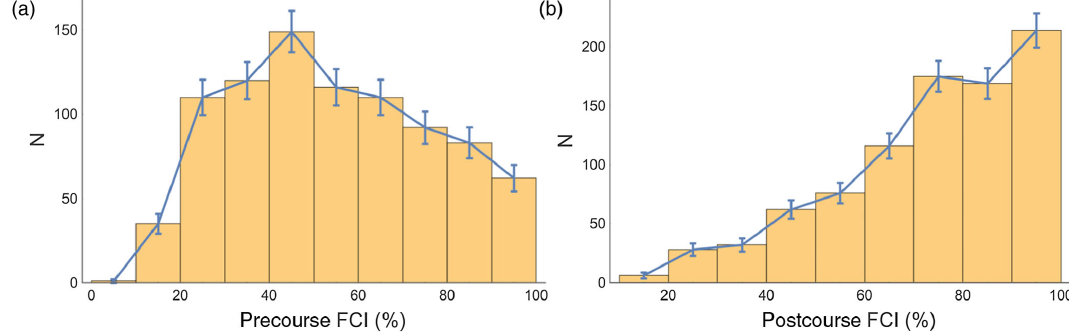
FIG. 1. FCI scores: (a) precourse, (b)